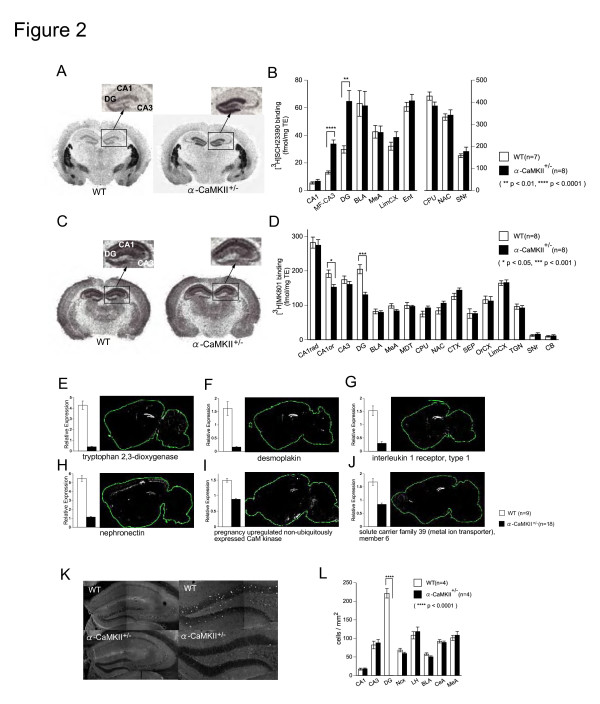
Specific Abnormalities in the DG of Alpha-CaMKII+/- Mice. (A, B) Dopamine D1 receptor binding was highly increased in the DG of alpha-CaMKII+/- mice. (C, D) NMDA receptor binding was similarly downregulated in the DG and CA1 of alpha-CaMKII+/- mice. (E-J) Among the downregulated genes in the hippocampus of alpha-CaMKII+/- mice, several genes were expressed selectively in the DG (Allen Brain Atlas [23] [Internet]. Seattle, WA: Allen Institute for Brain Science. © 2004–2008. Available from: .). Graphs indicate the relative expression levels of each gene in the microarray experiment, which are confirmed by quantitative RT-PCR (see Additional file 1, Figure S6). (K, L) c-Fos expression following electric foot shock was selectively decreased in the DG of mutant mice at the age of 8 weeks. BLA, basolateral amygdaloid nucleus; MeA, medial amygdaloid nucleus; LimCX, limbic cortex; Ent, entorhinal cortex; CPU, caudate nucleus/putamen; NAC, nucleus accumbens; SNr, substantia nigra pars reticulata; CA1rad, stratum radiatum of CA1; CA1or, stratum oriens of CA1; MDT, mediodorsal thalamic nucleus; CTX, cingulated cortex; SEP, septum; OrCX, orbital cortex; TGN, tegmental nuclei; CB, cerebellum; Ncx, neocortex; LH, lateral hypothalamus; CeA, central amygdaloid nucleus. * P < 0.05, ** P < 0.01, *** P < 0.001, **** P < 0.0001. Error bars indicate s.e.m.